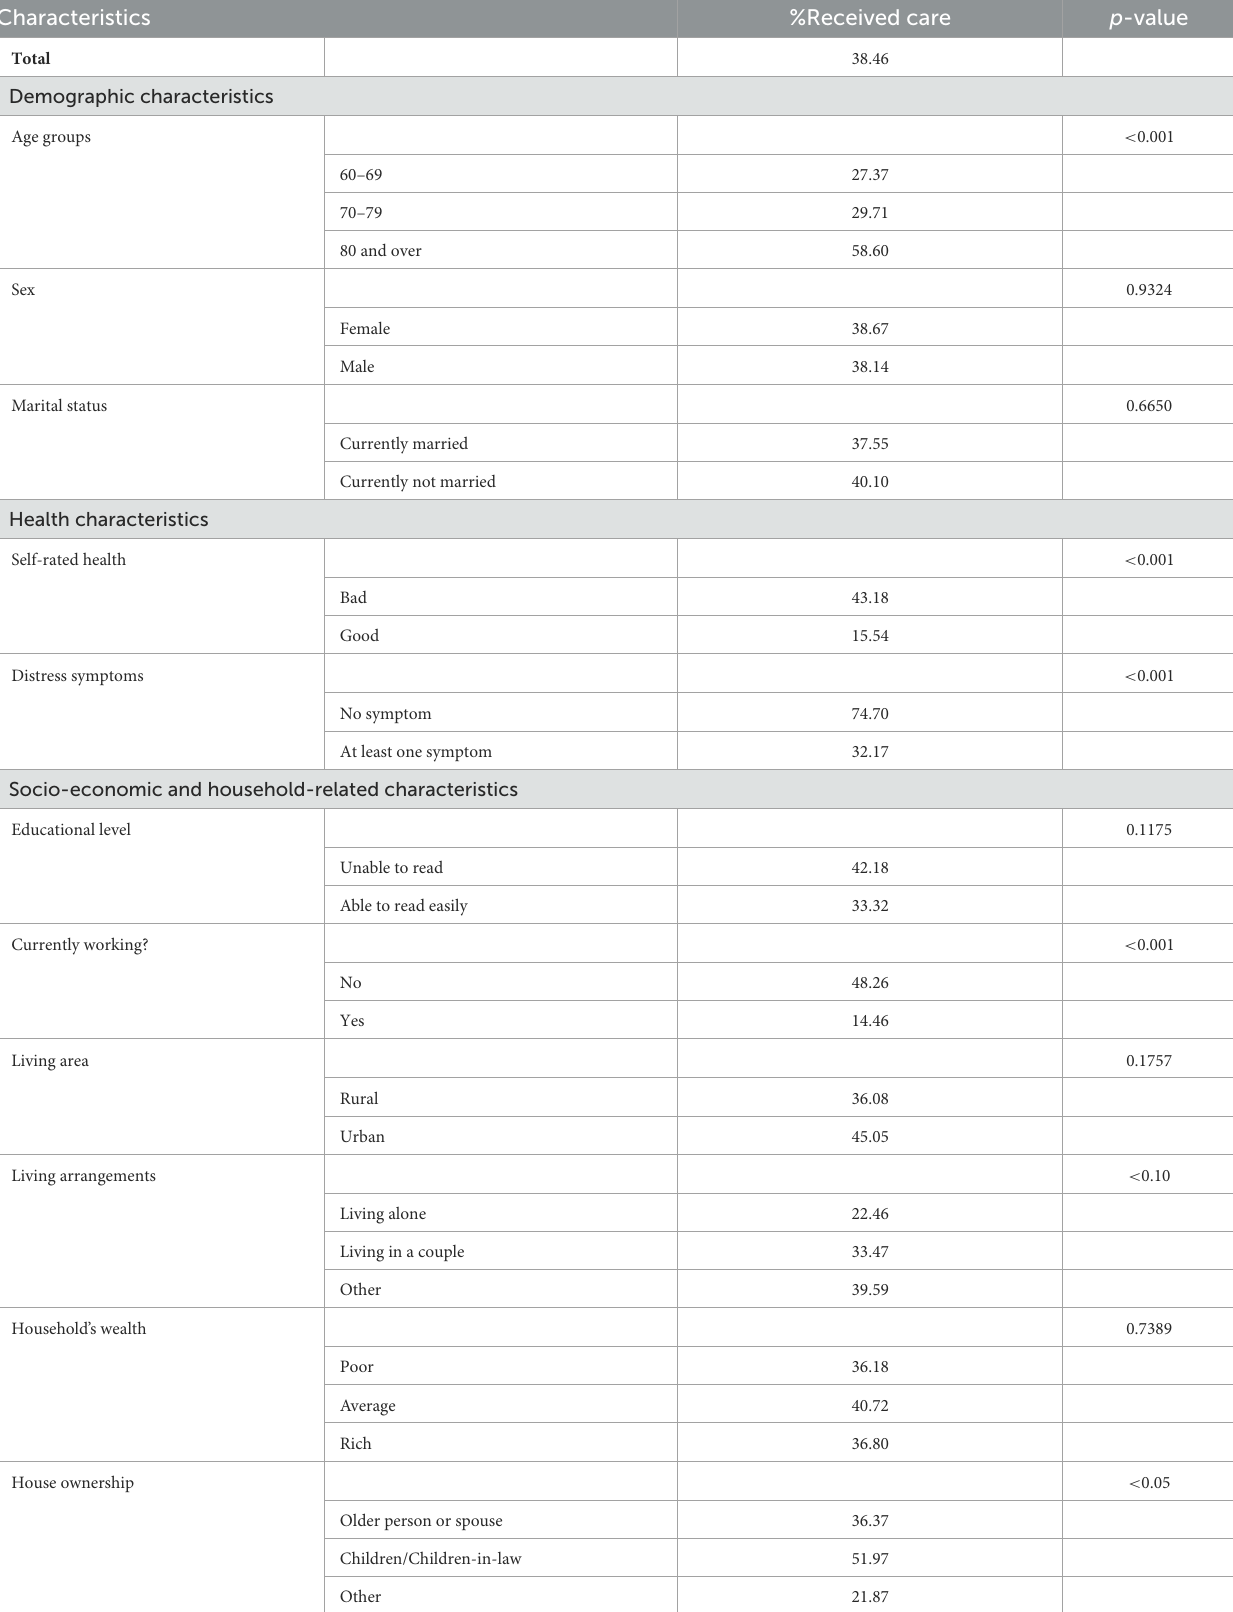
TABLE 2 Percentage of receiving care in any ADL by older